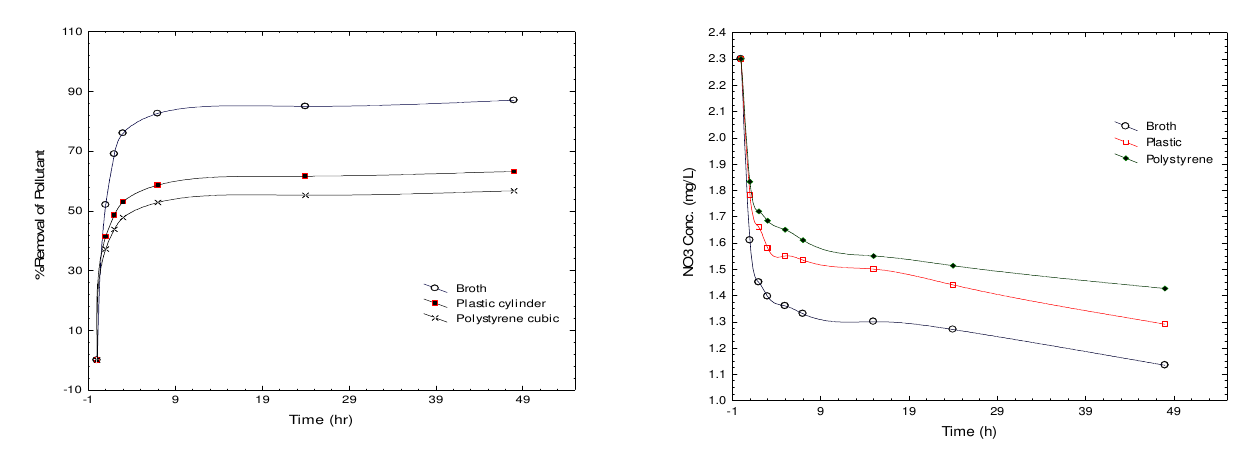
Fig. 15. Effect of Packing type on the Removal percent of TOC pollutant with time at T=25 o C, pH 7, and sterilized wastewater.